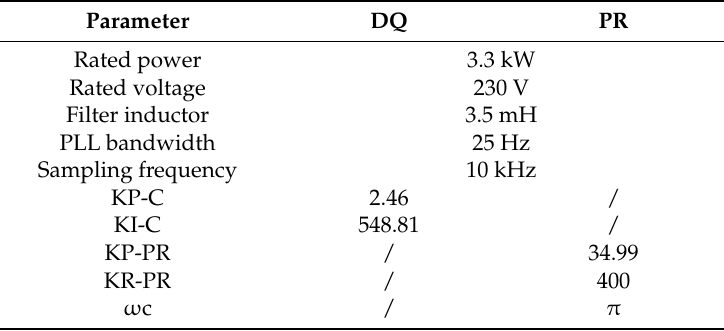
Table 1. The parameters of the